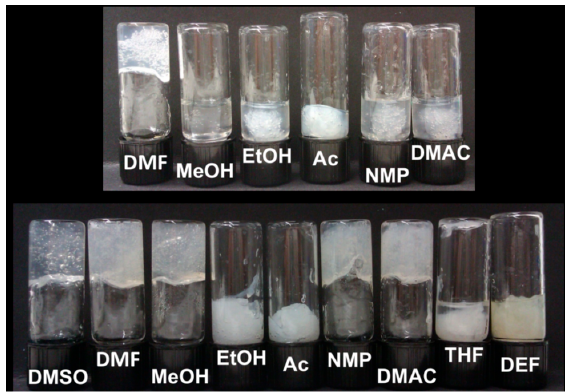
Figure 3. Effect of addition of 1 mL of solvents to 1 mL of 2% w / v (upper panel) or 4% w / v (lower panel) sodium alginate aqueous solution. Solvents used: dimethyl sulfoxide (DMSO), dimethylformamide (DMF), dimethylacetamide (DMAC), N -methyl-2-pyrrolidone (NMP), diethylformamide (DEF), tetrahydrofuran (THF), acetone (Ac), methanol (MeOH) and ethanol (EtOH). Reprinted with permission from Pérez-Madrigal et al. [31]. Copyright (2017), American Chemical Society.